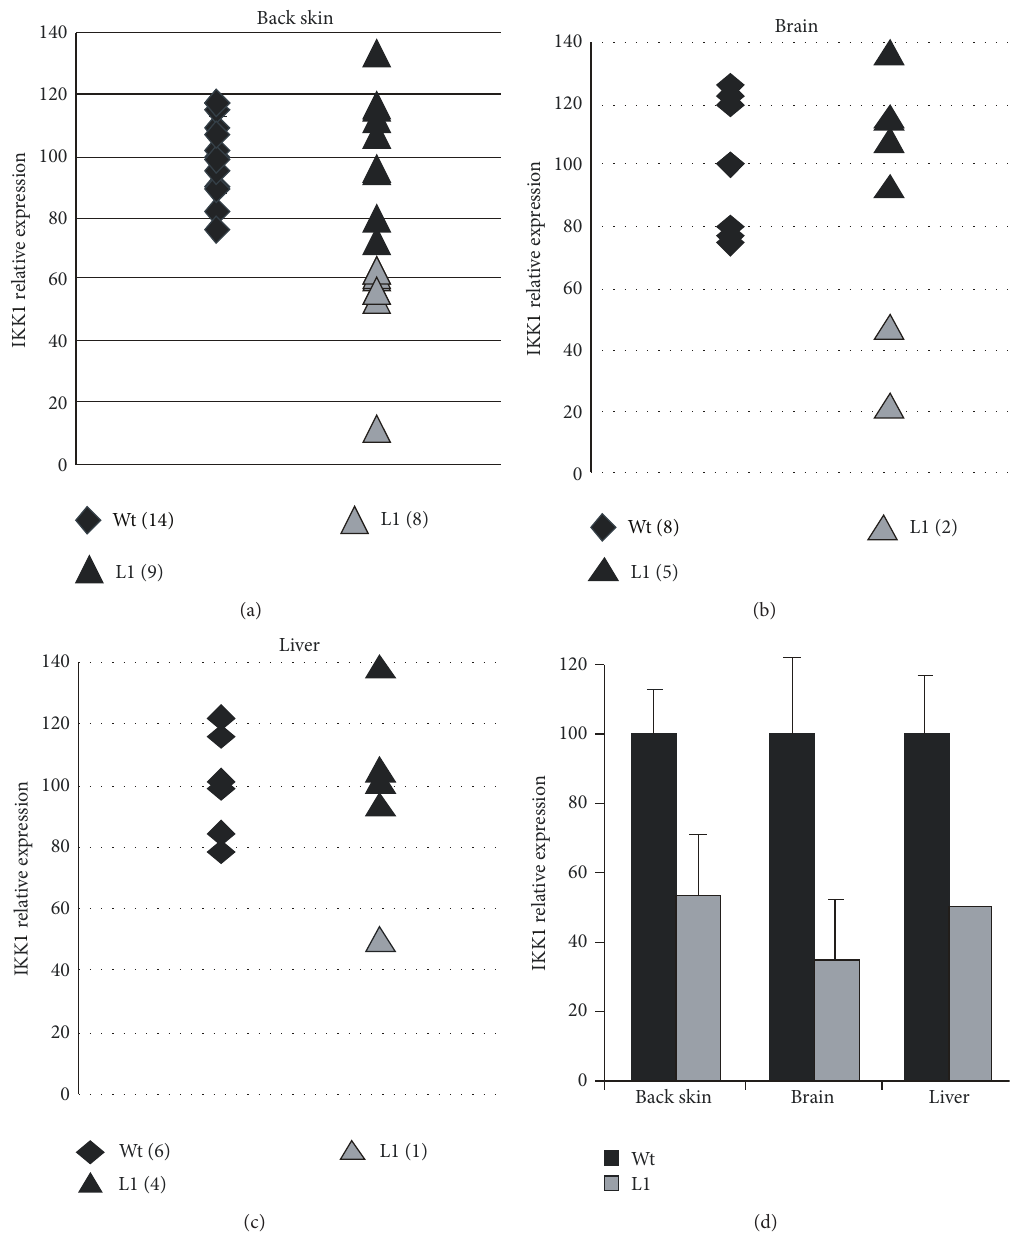
Figure 4: Reduced IKK1 mRNA expression in some H1-IKK1-siRNA transgenic mice. (a) IKK1 qRT-PCR analysis in back skin. Each value is presented as a percentage against the media obtained for wild-type mice. Diamonds indicate the values obtained for Wt mice and triangles those obtained for Tg mice. Grey triangles represent Tg mice with diminished (65% or below) IKK1 expression level. The number of mice analysed belonging to each category is indicated. ((b), (c)) Similar analysis as in (a), but for brain and liver, respectively. (d) Bar chart of the expression level of those L1 mice with diminished IKK1 expression